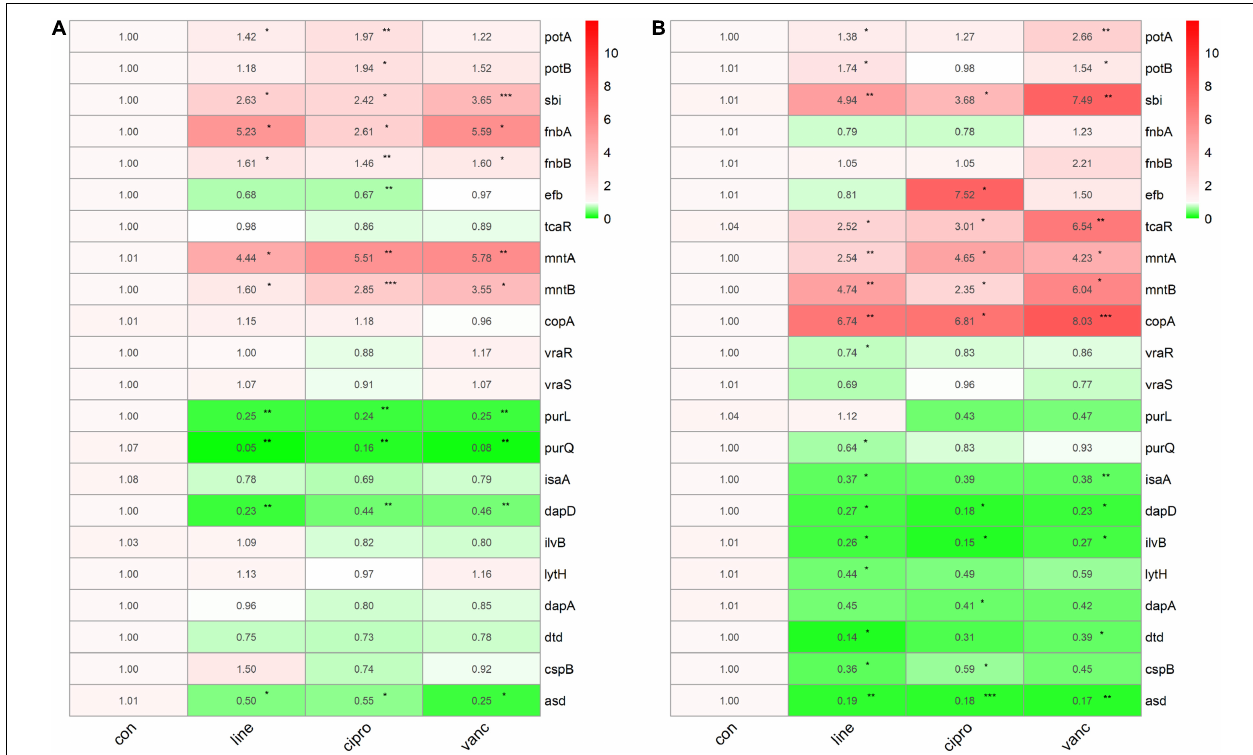
FIGURE 8 | The qPCR data of antimicrobials treated ST1792. The gyrB normalized transcription of ST1792 during logarithmic phase (A) and stationary phase (B) . Statistical significance was calculated using ANOVA with Dunnett multiple column comparisons. * p < 0.05; ** p < 0.01; *** p < 0.001 vs. non-treated control.